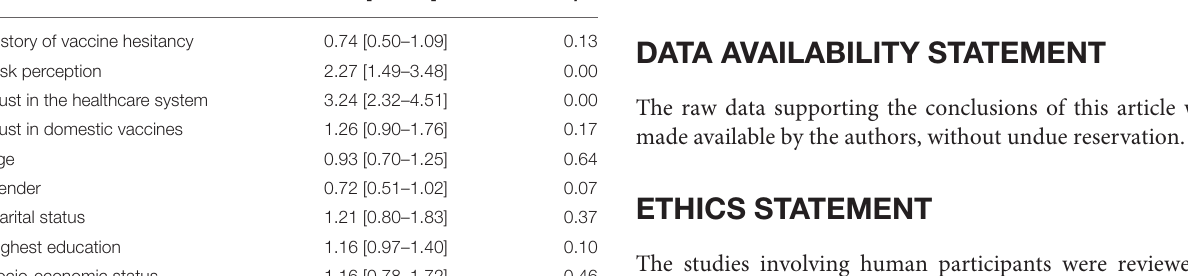
TABLE 5 | Multivariable regression analysis of the influencing factors on the COVID-19 vaccine uptake among study participants. Variable History of vaccine